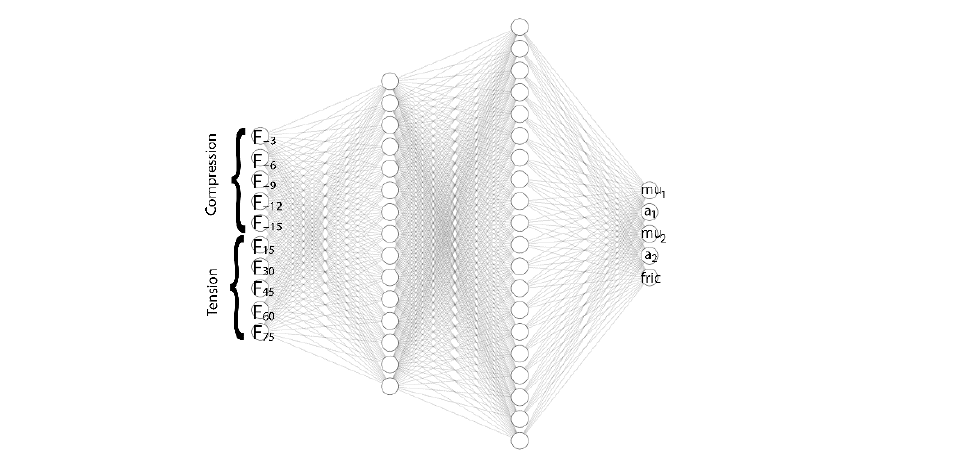
Figure 10. ANN structure with two hidden layers.